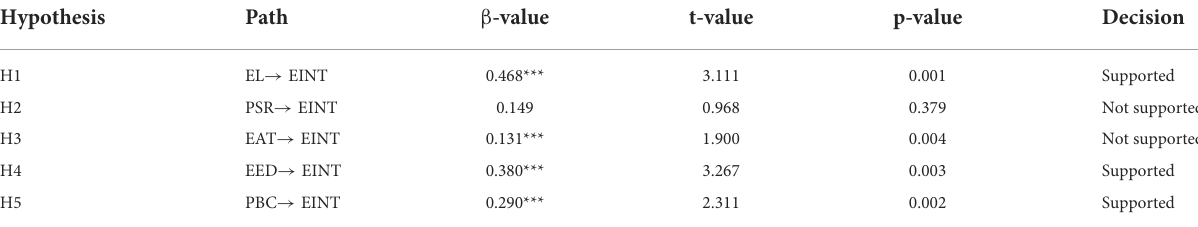
TABLE 5 Result of hypothesis